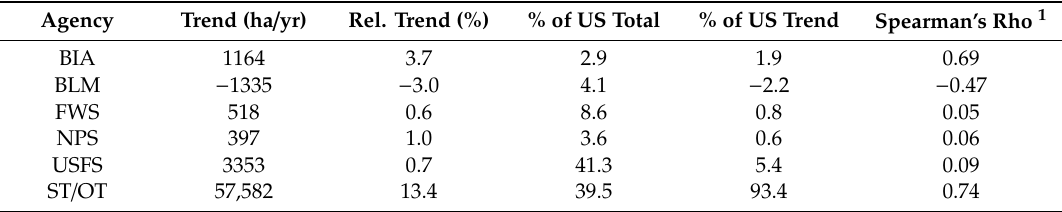
Table 2. Trends in prescribed fire accomplishments in the United States (US) by agency from 1998 to 2018, including raw trend (mean ha/year), relative trend (normalized by mean accomplishment for a given agency), percent of the total US accomplishment, percent of the total US trend, and Spearman’s Rho to indicate the strength of the trend. Agencies are Bureau of Indian Affairs (BIA), Bureau of Land Management (BLM), Fish and Wildlife Service (FWS), National Park Service (NPS), US Forest Service (USFS), and other federal (e.g., Defense, Energy, and Reclamation), non-federal, state, and municipal agencies that report to the National Interagency Fire Center (NIFC) (State/Other, ST/OT). Agency Trend (ha/yr) Rel. Trend (%) % of US total % of US trend